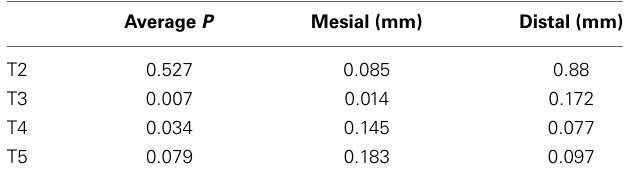
Table 2 | Statistical outcome of MBL using the linear mixed